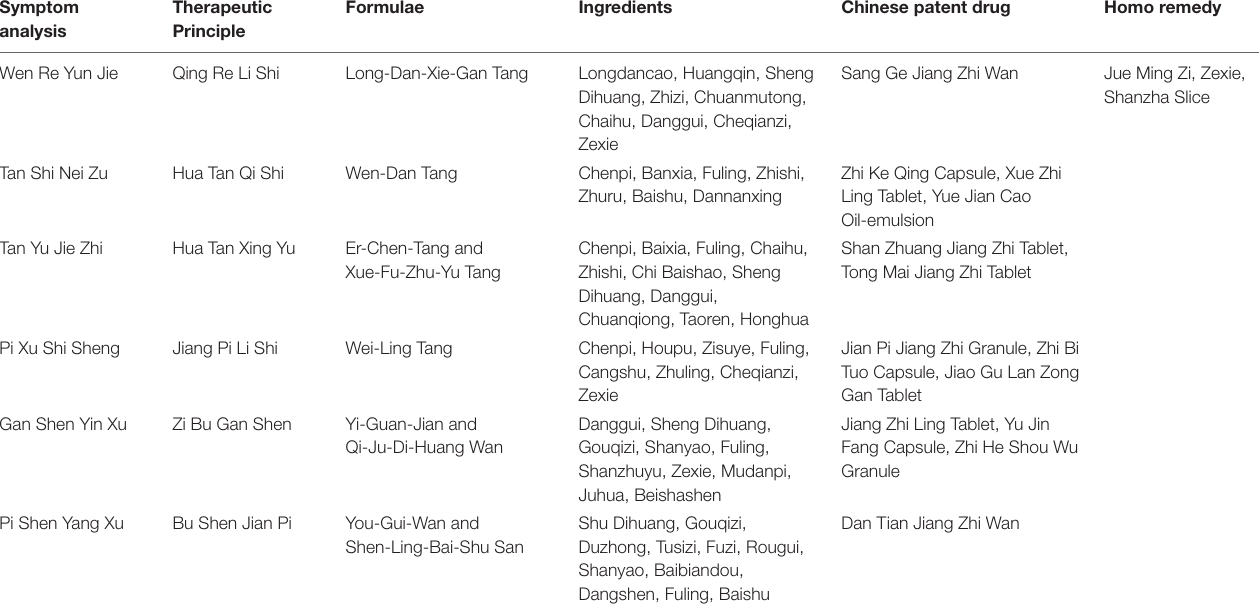
Formulae should be modified according to specific syndromes and clinical manifestations.